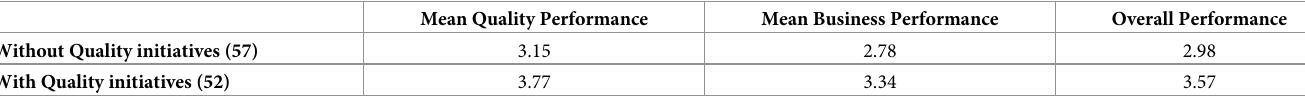
Table 13. Comparison of performance of hospitals with and without quality